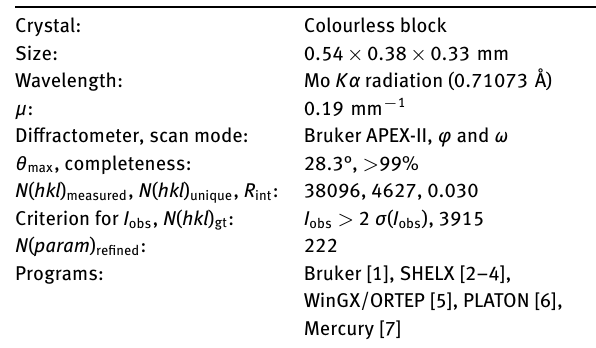
Table 2: Fractional atomic coordinates and isotropic or